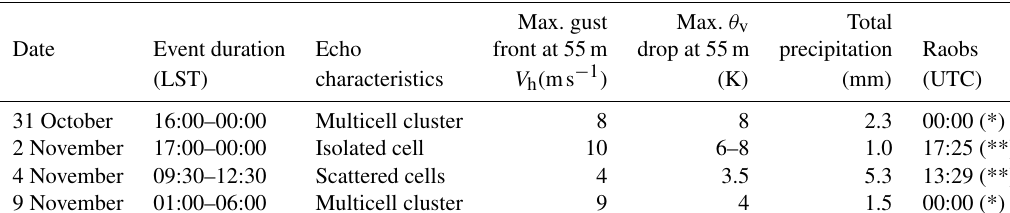
Table 1. Main characteristics of the four storm events investigated in this study. (*) indicates Ponta Pelada Airport operational soundings in Manaus (SBMN; lower resolution). (**) indicates soundings taken at Campina site (2 ◦ 10 (cid:48) 53.72 (cid:48)(cid:48) S, 59 ◦ 01 (cid:48) 18.36 (cid:48)(cid:48) W; 48.4m a.s.l.).